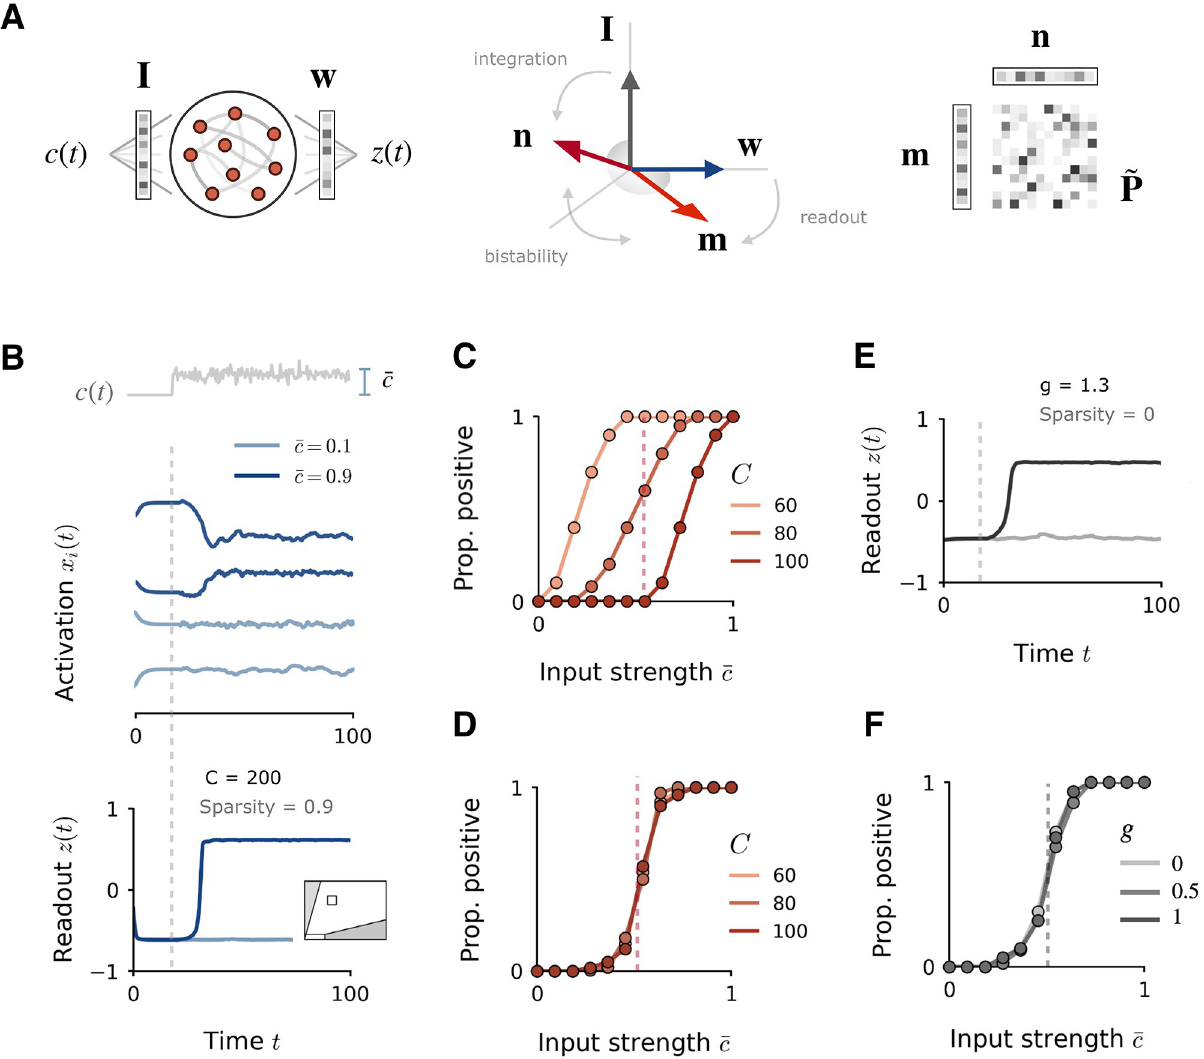
Fig 6. Implementation of input integration task in rank-one networks at high sparsity. A : Illustration of recurrent network structure (left), geometrical configuration of input, readout and connectivity vectors (centre), and construction of sparse rank-one connectivity matrix (right). B : Implementation of the task in a sparse network ( s = 0.9, C = 200 and N = 2000). Top: sample of fluctuating inputs, with magnitude set by strength parameter � c . Centre: examples of network activations x ( t ), for high and low stimulus strengths (dark and light blue). Bottom: corresponding readout z i ( t ) for high and low stimulus strengths. Network is parameterised by variance σ 2 = 0.1 and covariance σ mn = 0.04, located at the white square on the phase diagram in the inset. C : Psychometric curve for different sparsity levels C , indicating the proportion of positive readouts produced as the stimulus strength is increased. The dashed line indicates the threshold stimulus strength for which the readout should switch from positive to negative. The proportion is defined as the fraction of times, over 50 repeats, that the mean readout (taken over the final 50ms of stimulus presentation) is positive. All other parameters are held fixed ( σ 2 = 0.1, σ mn = 0.06 and N = 2000) D : Psychometric curve for different sparsity levels C , with the outlier held fixed at a constant value of λ 1 = 8. The different values in C result in bulk distributions with spectral radii of 0.76, 0.87 and 0.97 respectively. E : Readout dynamics for task implemented in a network composed of a dense low-rank component plus a Gaussian component, parameterised to ensure the equivalent outlier and spectral radius to the sparse network in B (network defined by J ij + m i n j , with J ij as in Eq 12, σ 2 = 9, σ mn = 2.3, g = 1.3). F : Psychometric curve of low-rank-plus-Gaussian network for different random strengths, g , with the outlier fixed to the same value as the sparse network in D .